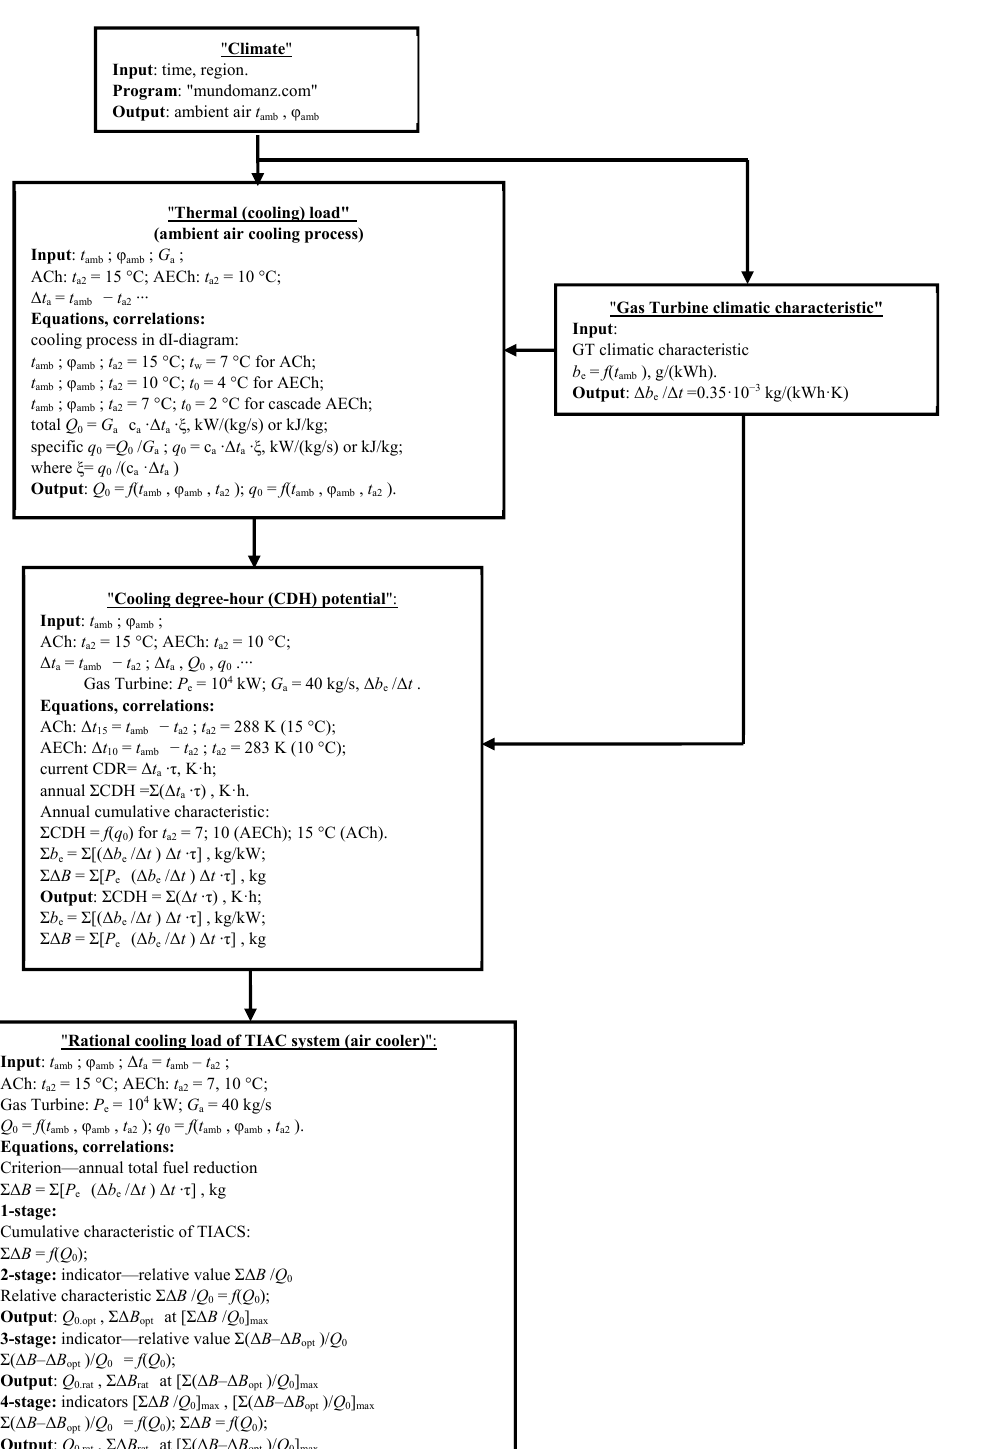
Figure A1. Flow chart of calculation procedure.